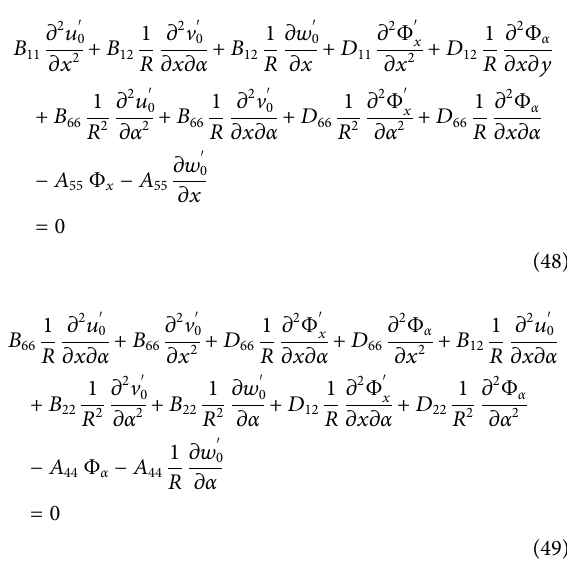
For a simply supported composite closed cylindrical shell, the following relations are chosen for the solution of stability equations (Geier and Singh, 1997; Messager et al., 2002).